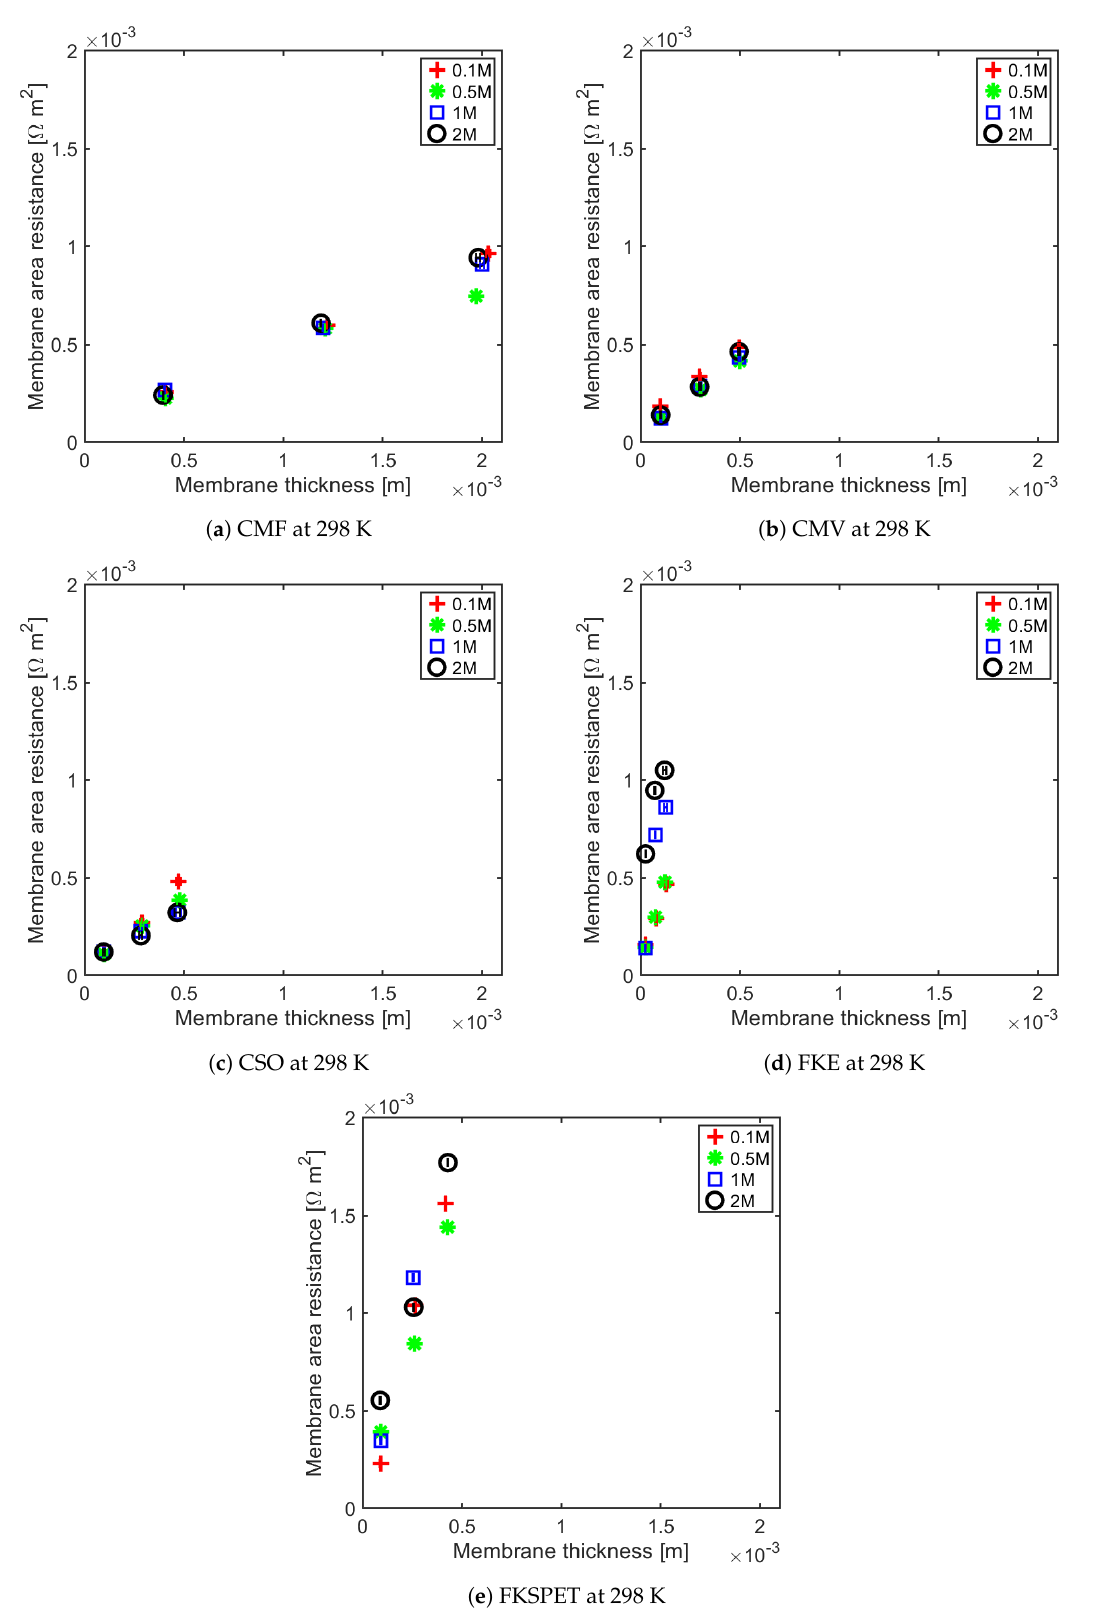
Figure 7. Cation exchange membrane (CEM) resistance as a function of thickness for different concentrations at 298